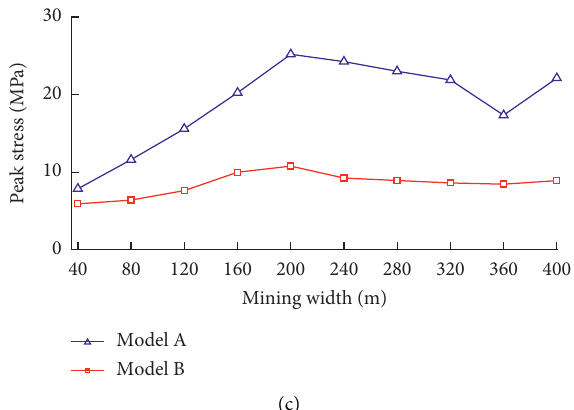
Figure 6: Mining-induced stress distribution. (a) Vertical stress distribution of the lower seam after the extraction of the upper seam. (b) Vertical stress distribution when the length of the panel was 200m. (c) Variation of peak stress concentration factors of the advanced abutment pressure in lower